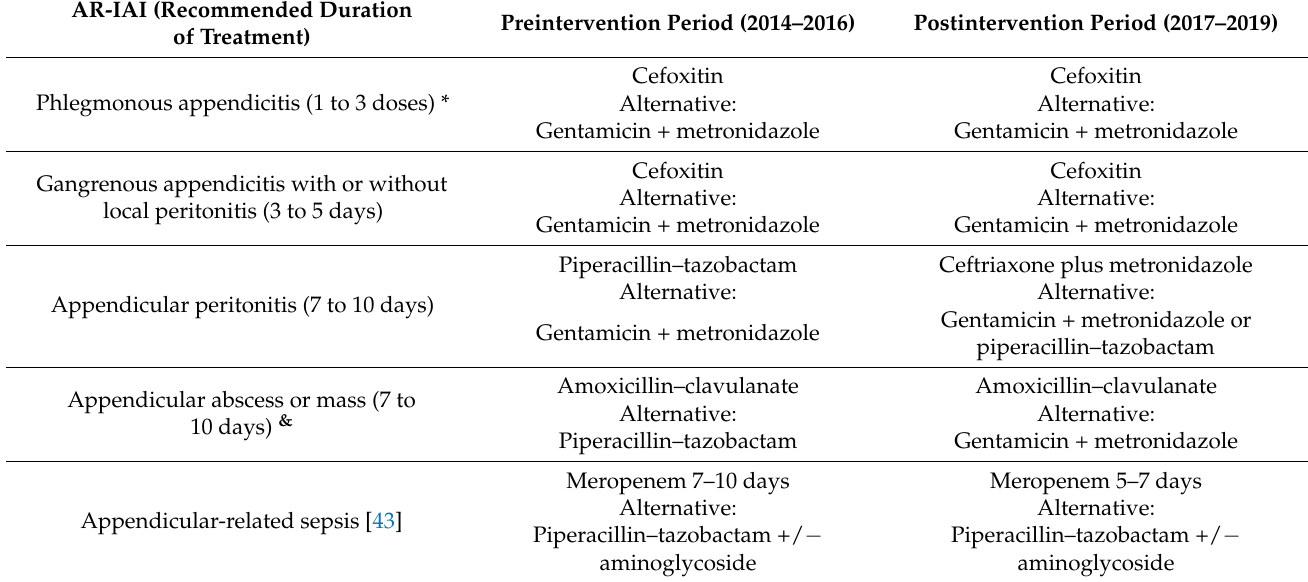
Table 2. Recommended first-line and preferred alternative antimicrobial regimens in appendix-related intraabdominal infections (AR-IAI) during the study